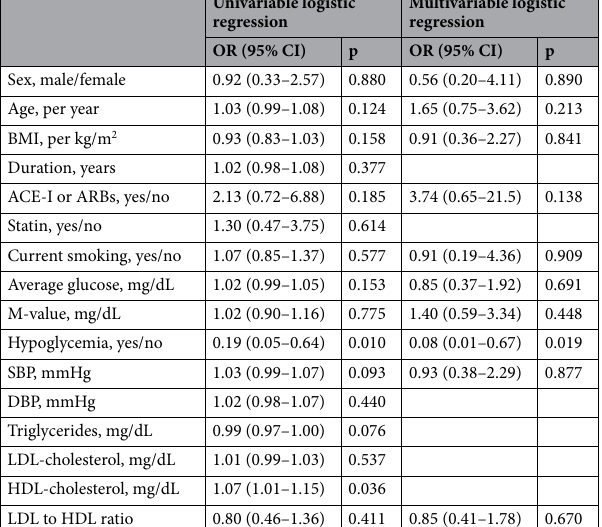
Table 4. Clinical markers associated with L_RHI ≥ 0.51 at discharge. L_RHI, natural logarithmic scaled reactive hyperemia index; OR, odds ratio; CI, confidence interval; BMI, body mass index; ACE-I, angiotensin- converting enzyme inhibitor; ARB, angiotensin receptor blocker; SBP, systolic blood pressure; DBP, diastolic blood pressure; LDL, low-density lipoprotein; HDL, high-density lipoprotein.